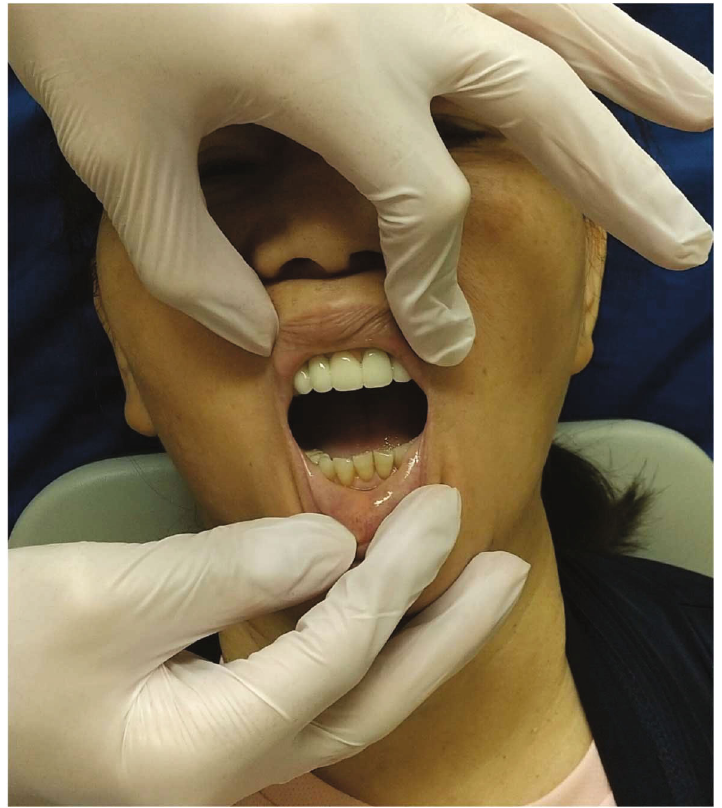
Figure 4: Before the JMUI